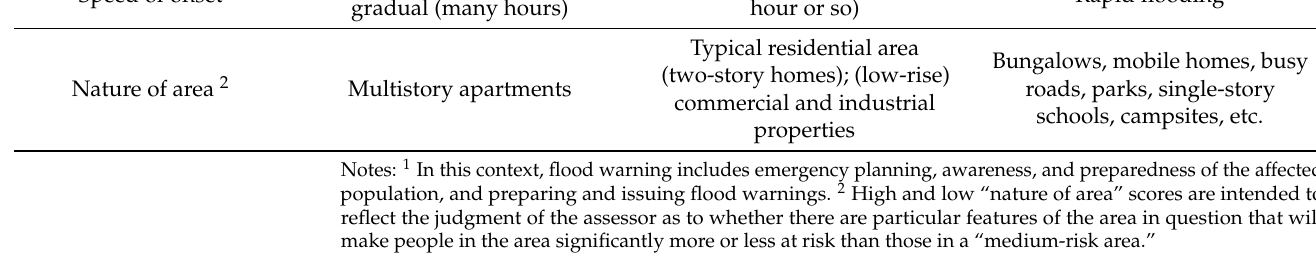
Table 3. Area vulnerability